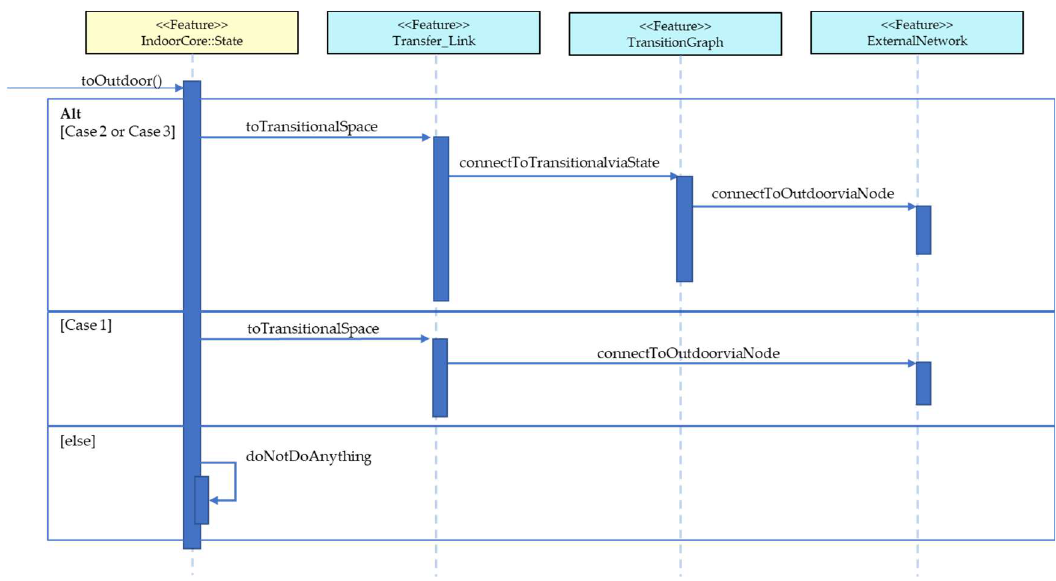
Figure 8. UML sequence diagram involving three cases of transitional spaces in the proposed model.